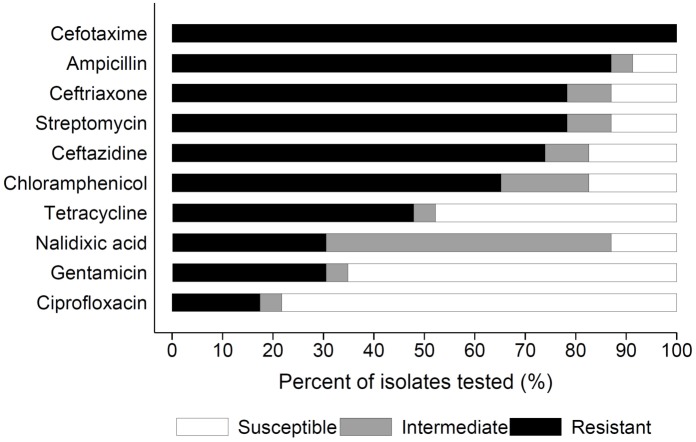
Antimicrobial Susceptibility Test.The antibiotic susceptibility test results of the 23 cefotaxime resistant bacterial isolates toward ten different antimicrobial compounds are presented as the percentage (%) of isolates that exhibited complete resistance black, intermediate resistance gray, and no resistance white to the antibiotics listed on the y axis.